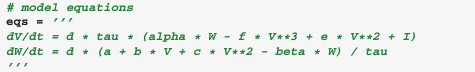
with the sensors positions and an interactive time-series display. (D) An animated display of the spatiotemporal pattern applied to the cortical surface. Red spots represent the focal points of the spatial component of the stimulus.